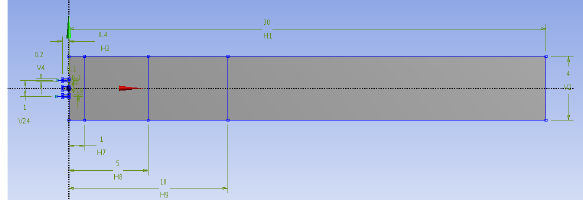
Figure 2: The geometry of confined space: S/H = 0.25, γ = 0.15 and D = 0.2 m